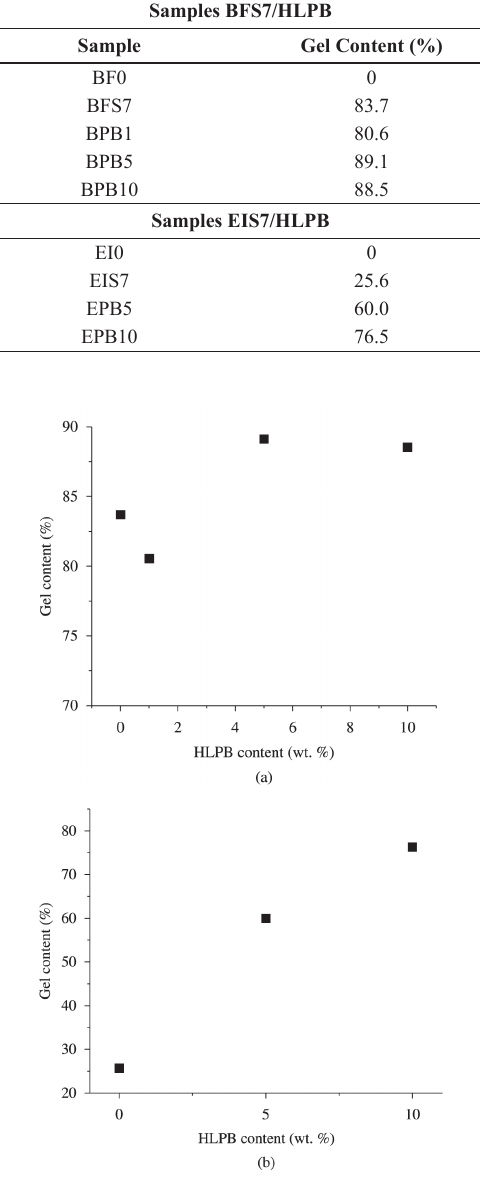
Figure 6. Gel content of samples: (a) BFS7/HLPB; (b) EIS7/HLPB.